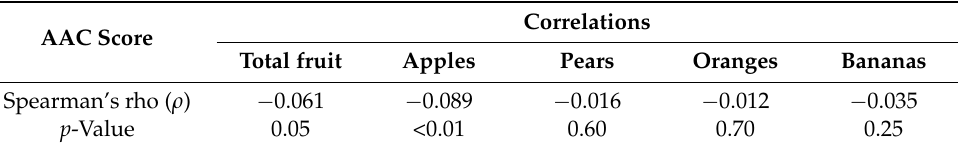
Table 2. Spearman’s Correlation of Abdominal Aortic Calcification (AAC) scores at baseline with total fruit and individual fruit (apples, pears, oranges and bananas) consumption at baseline (g/day).